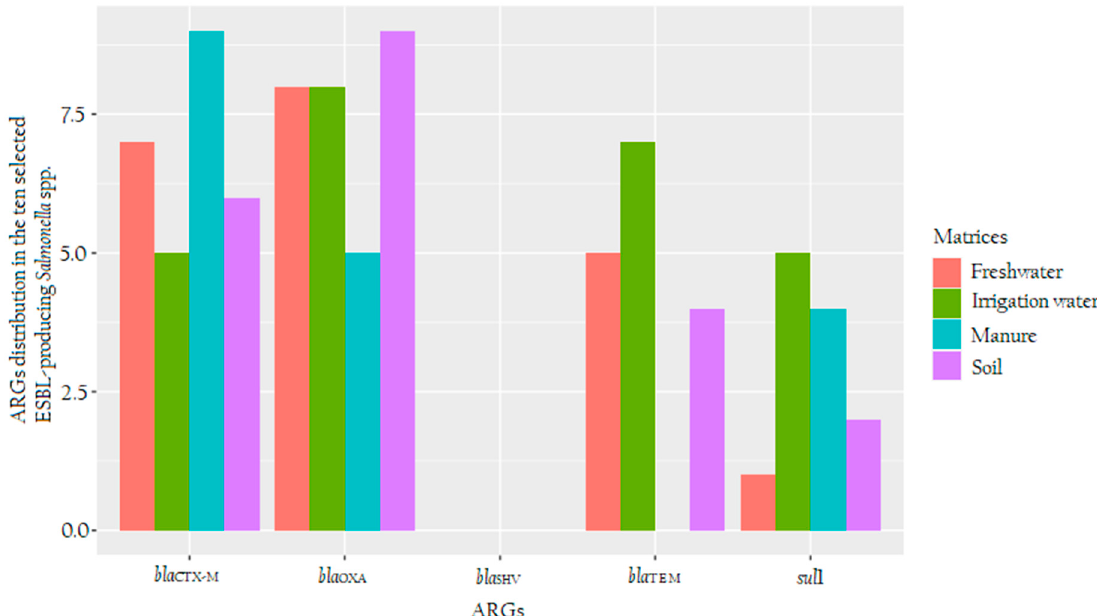
Figure 2. A clustered barplot showing the distribution of antibiotic-resistant genes (ARGs) detected in the ten randomly selected ESBL-producing Salmonella spp. from soil (purple), manure (turquoise), irrigation water (green) and nearby freshwater (red). The X-axis shows the five targeted ARGs, whereas the Y-axis shows the number of ARGs found in each assessed matrix.